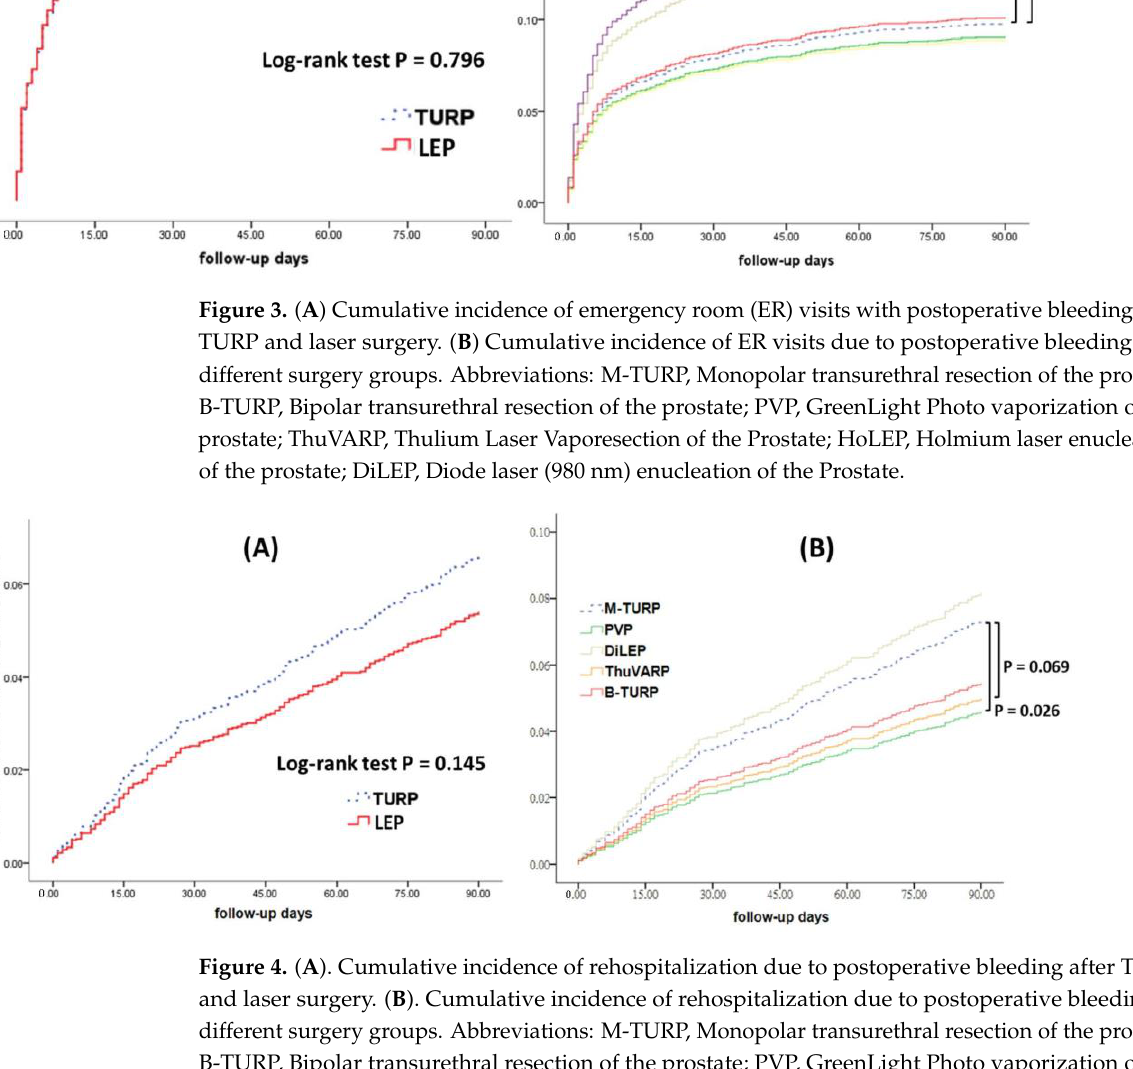
Figure 4. ( A ). Cumulative incidence of rehospitalization due to postoperative bleeding after TURP and laser surgery. ( B ). Cumulative incidence of rehospitalization due to postoperative bleeding in different surgery groups. Abbreviations: M-TURP, Monopolar transurethral resection of the prostate; B-TURP, Bipolar transurethral resection of the prostate; PVP, GreenLight Photo vaporization of the prostate; ThuVARP, Thulium Laser Vaporesection of the Prostate; HoLEP, Holmium laser enucleation of the prostate; DiLEP, Diode laser (980 nm) enucleation of the Prostate.